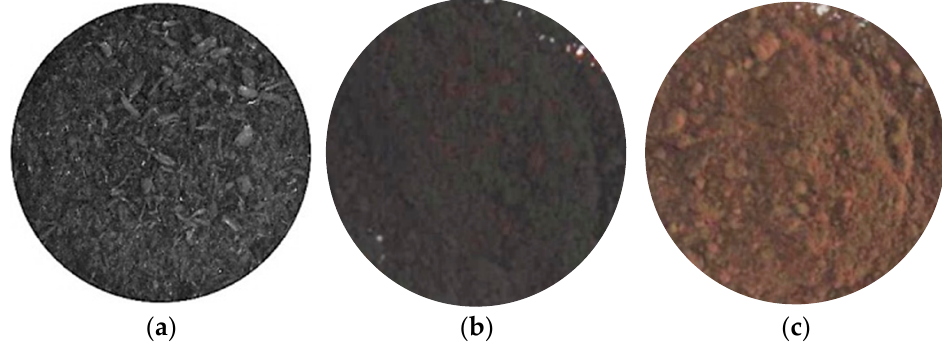
Figure 8. SCBA images: ( a ) SCBA AC; ( b ) SCBA G; and ( c ) SCBA RG.